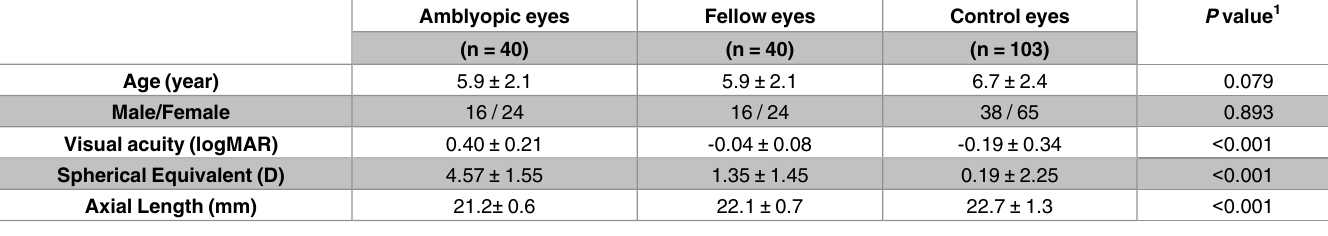
Table 1. Demographic information of the amblyopic patients and